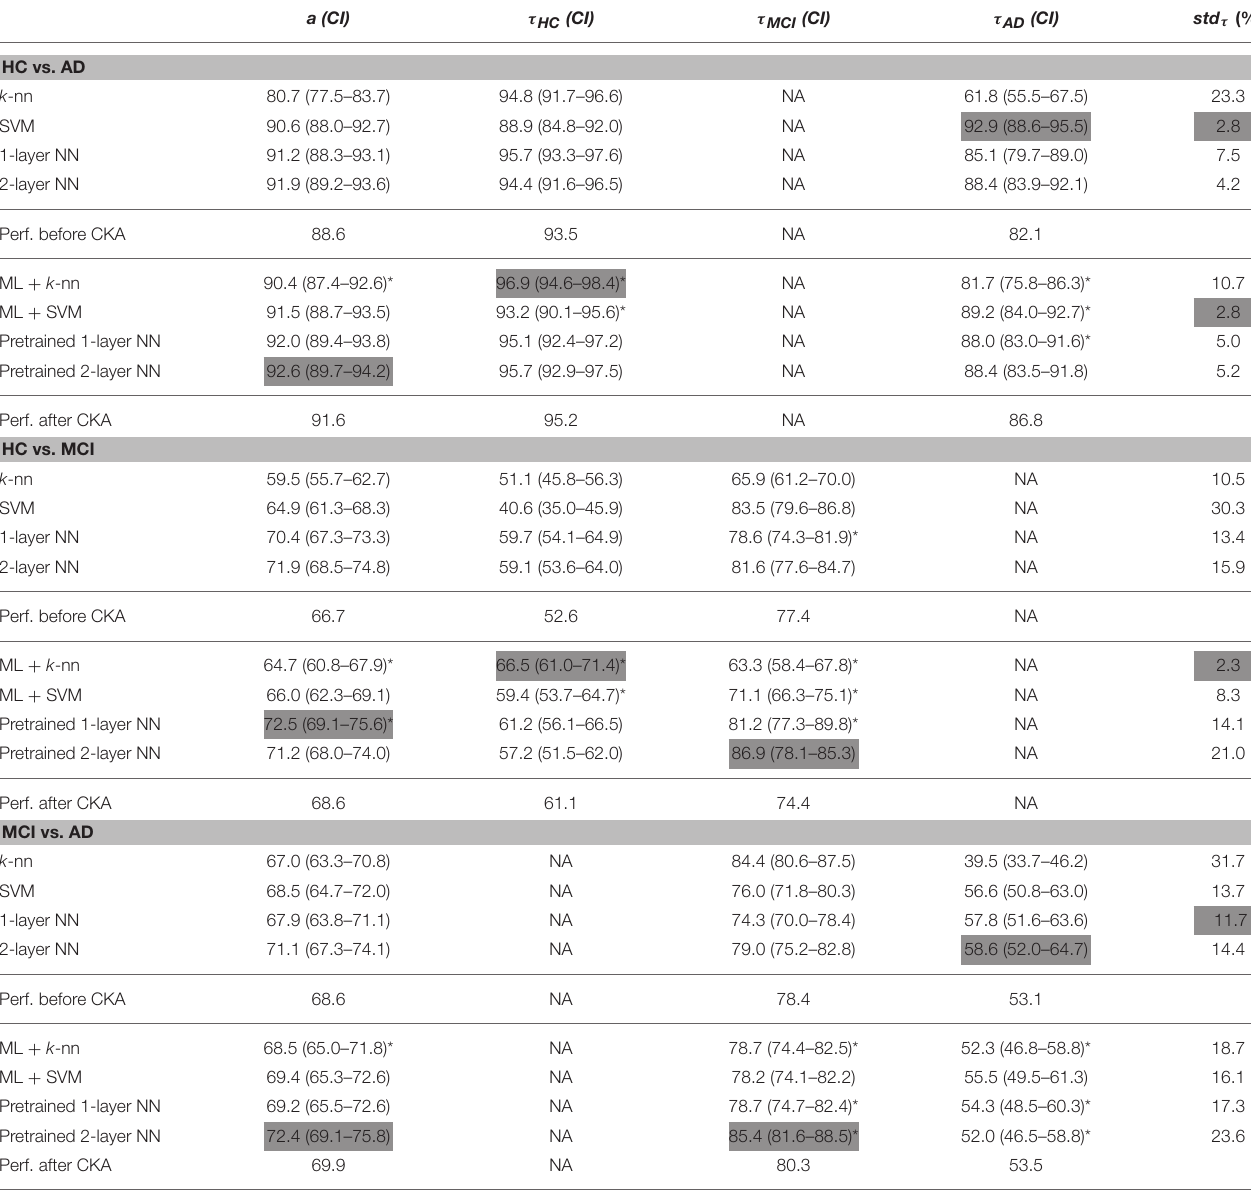
TABLE 4 | Testing performance of the metric learning for the bi-class task.